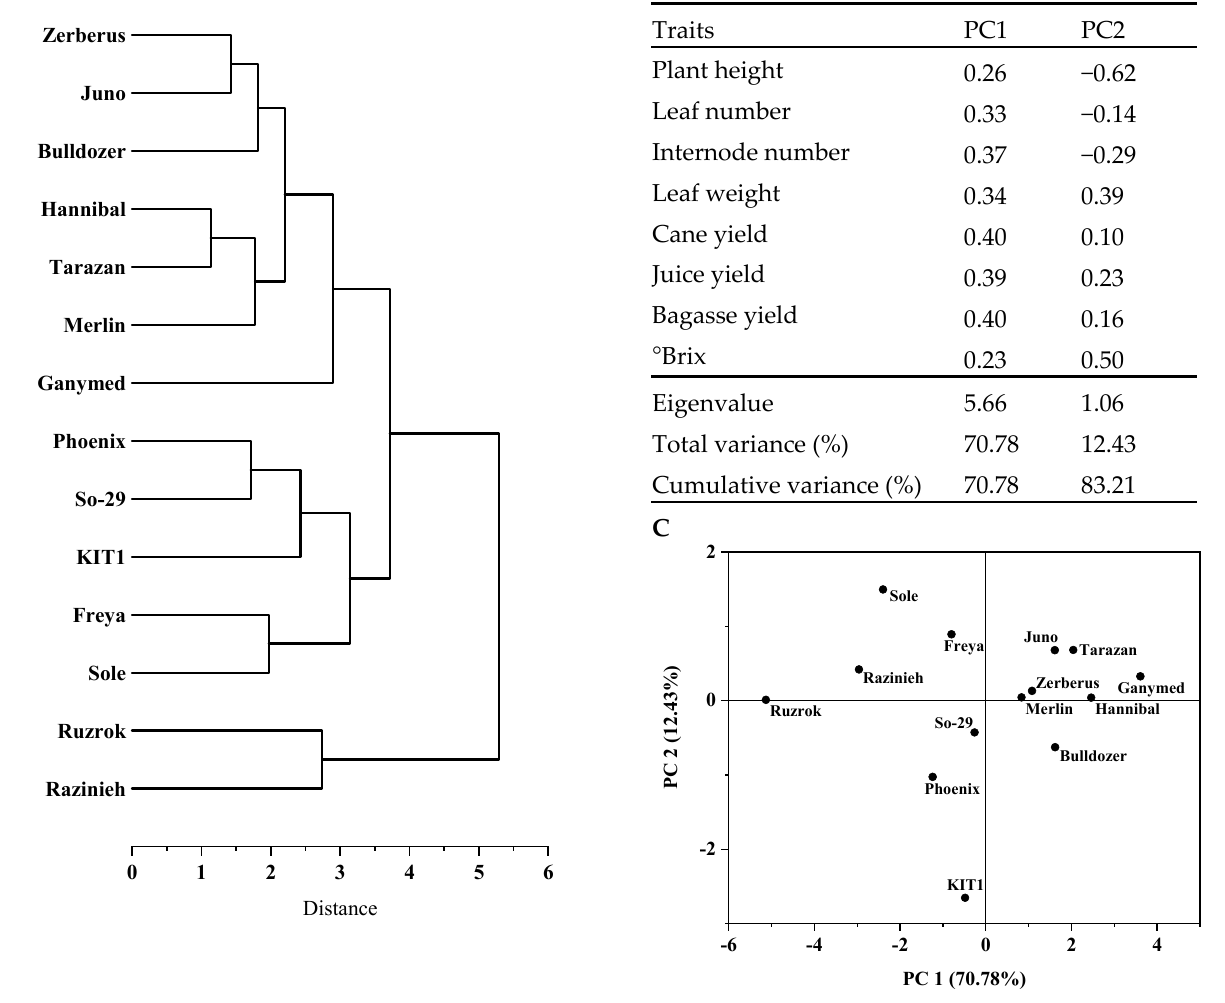
Figure 3. Clustering and principal component analysis based on 8 agro-morphological and sugar-related traits in 14 sorghum genotypes. ( A ) Dendrogram based on Euclidean distance and Average linkage method. ( B ) Eigenvectors, total variation, eigenvalue, and cumulative variance. ( C ) PCA plot showing scores for PC1 and PC2.